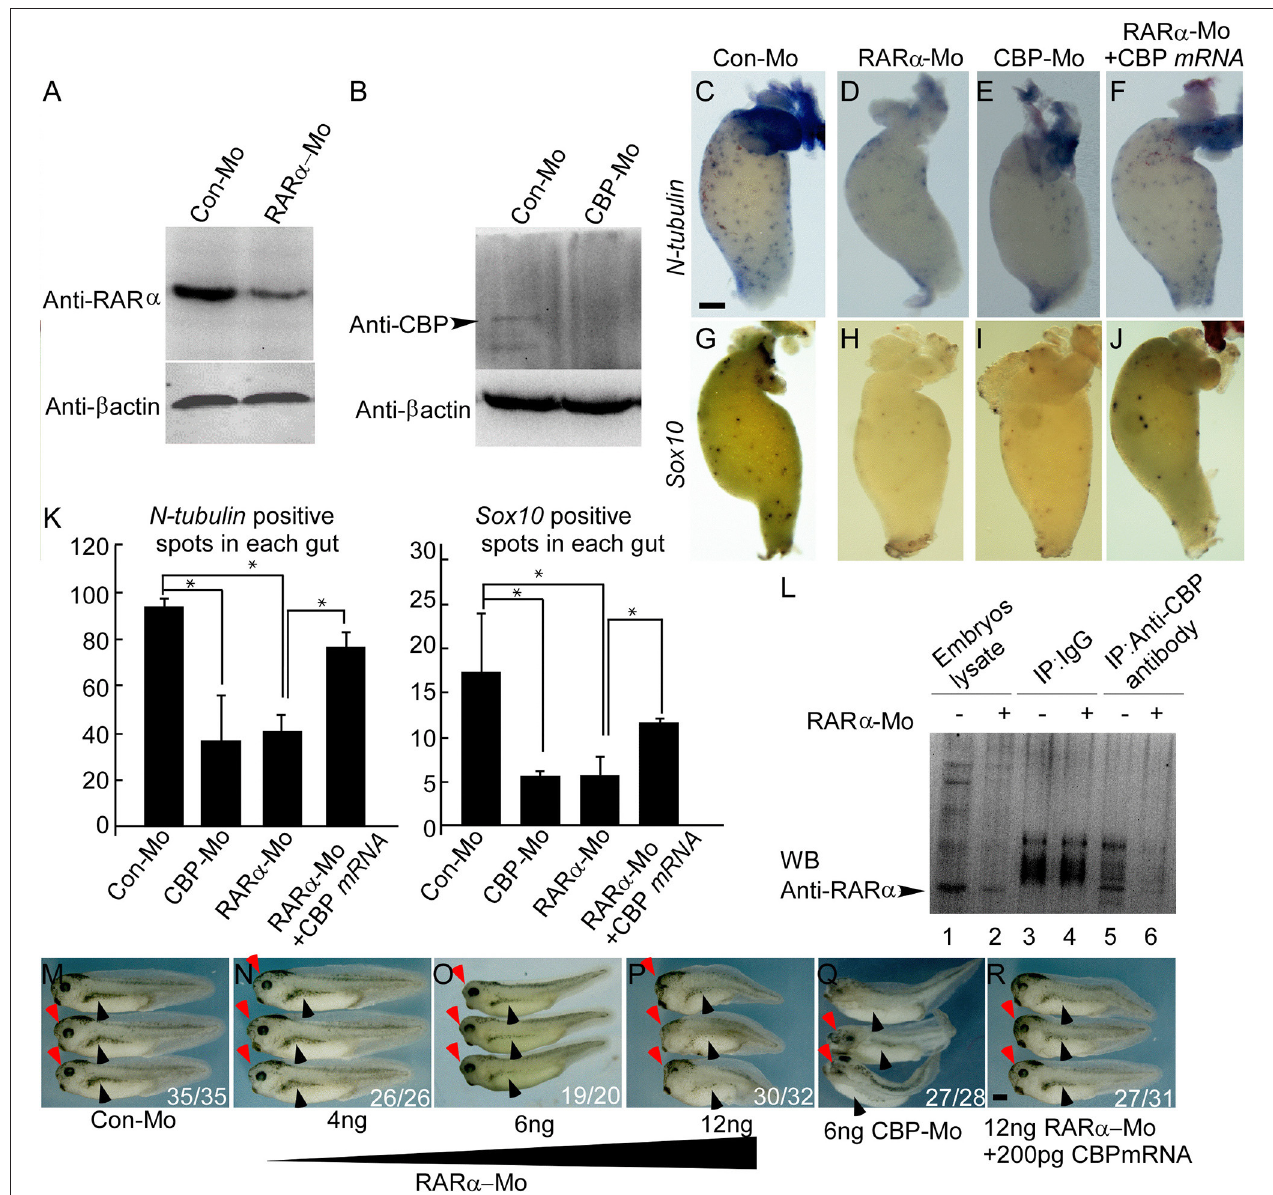
FIGURE 3 | RAR α and CBP are cooperatively required for enteric nervous cell development in Xenopus laevis . Morpholino-mediated knockdown of RAR α (A) or CBP (B) is efficient at embryonic stage 15. (C–J) RAR α (D,H) or CBP (E,I) knockdown decreases enteric nervous cells (labeled with N-tubulin) and enteric neural crest cells (labeled with Sox10) compared to control guts (C,G) . CBP mRNA coinjection rescues RAR α morpholino effects on the gut (F,J) . Gut anlage was harvested at stage 41. Enteric nervous cells are detected as dispersed blue-spots by N-tubulin in situ hybridization, whereas enteric neural crest are marked by Sox10. (K) Statistical analysis of enteric nervous cells among different groups. Nervous cells were quantified by counting the number of blue spots. In each group, at least three guts were analyzed and presented as the mean ± sd. (L) RAR α coimmunoprecipitates with CBP in stage 15 Xenopus laevis embryos. (M–R) RAR α morpholino injection at the 2- or 4-cell stage into the dorsal blastomere leads to dose-dependent microcephaly (red arrowhead) and pigment cell abnormalities (black arrowhead) at stage 37. (Q) CBP morpholino injection has similar phenotypes to RAR α knockdown. (R) CBP mRNA largely rescues the RAR α morphant small head and pigment deformity phenotypes. The numbers of embryos showing similar phenotypes and total injected embryos in each group are indicated. Scale bar: 100 µ m. * P < 0.05. ± 0.58) and N-tubulin-(77 ± 6.24) positive colony numbers differentiated nervous cells, as illustrated by N-tubulin in situ in RAR α morphant embryos ( P < 0.05) ( Figures 3F,J ). We hybridization, were consequently decreased (positive blue spots also observed microcephaly ( Figures 3M–Q red arrowhead) and 41.3 ± 7.23/gut in RAR α morphants, Figures 3D,K and 37 ± pigment cell abnormalities ( Figures 3M–Q black arrowhead) in 19.2/gut in CBP morphants Figures 3E,3K ) in the developing gut RAR α and CBP knock-down embryos. The severity of RAR α - anlage ( P < 0.05), which is a hypoganglionosis-like phenotype. MO phenotypes was Coinjection of CBP mRNA significantly rescued Sox10-(11.7